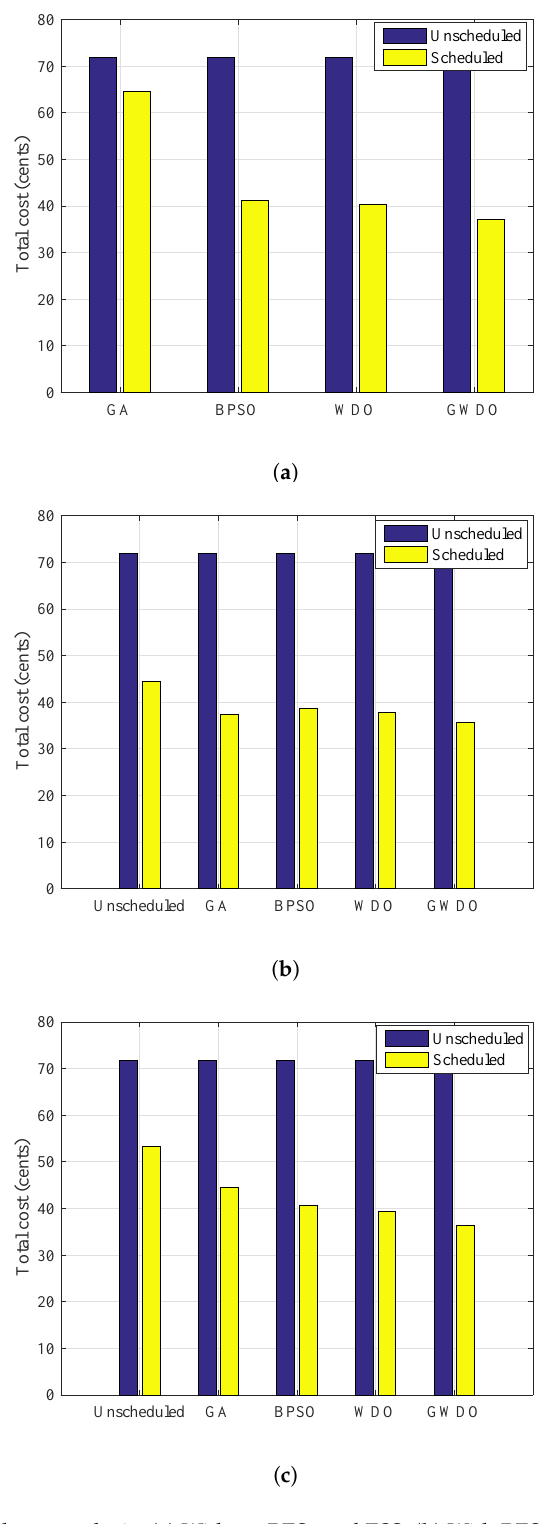
Figure 15. Aggregated cost analysis: ( a ) Without RESs and ESS; ( b ) With RESs; ( c ) With RESs and ESS. The aggregated cost analysis of scheduled load without RESs is shown in Figure 15a. The heuristic techniques GA, BPSO, WDO, and our proposed GWDO reduce the electricity cost by 4.2%,